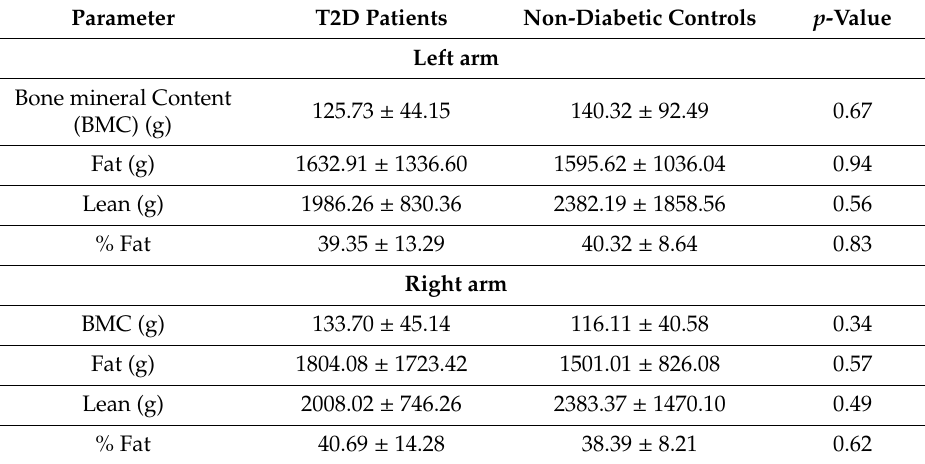
Table 4. Comparison of body composition on DEXA of upper limbs.